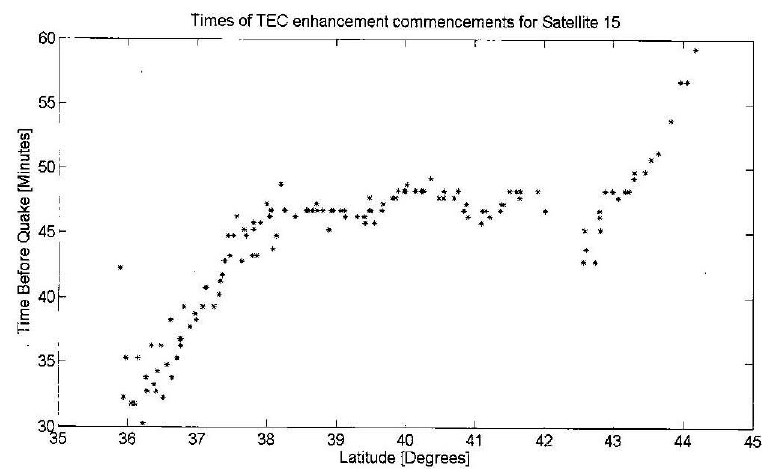
Figure 2. Time intervals between STEC enhancement commencements for latitudes between 38 ◦ and 43 ◦ . The simultaneously of the STEC enhancements show that they are tied to the earth and not due to a wave propagating in the atmosphere. The sloping points at latitudes below 38 ◦ and higher than 43 ◦ are due to propagating waves (After Kelley et al. 2017 [7], reproduced with permission of the American Geophysical Union).